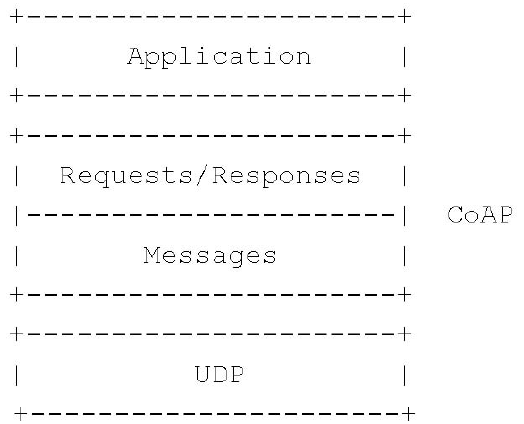
Figure 1. Layering of Constrained Application Protocol (CoAP).